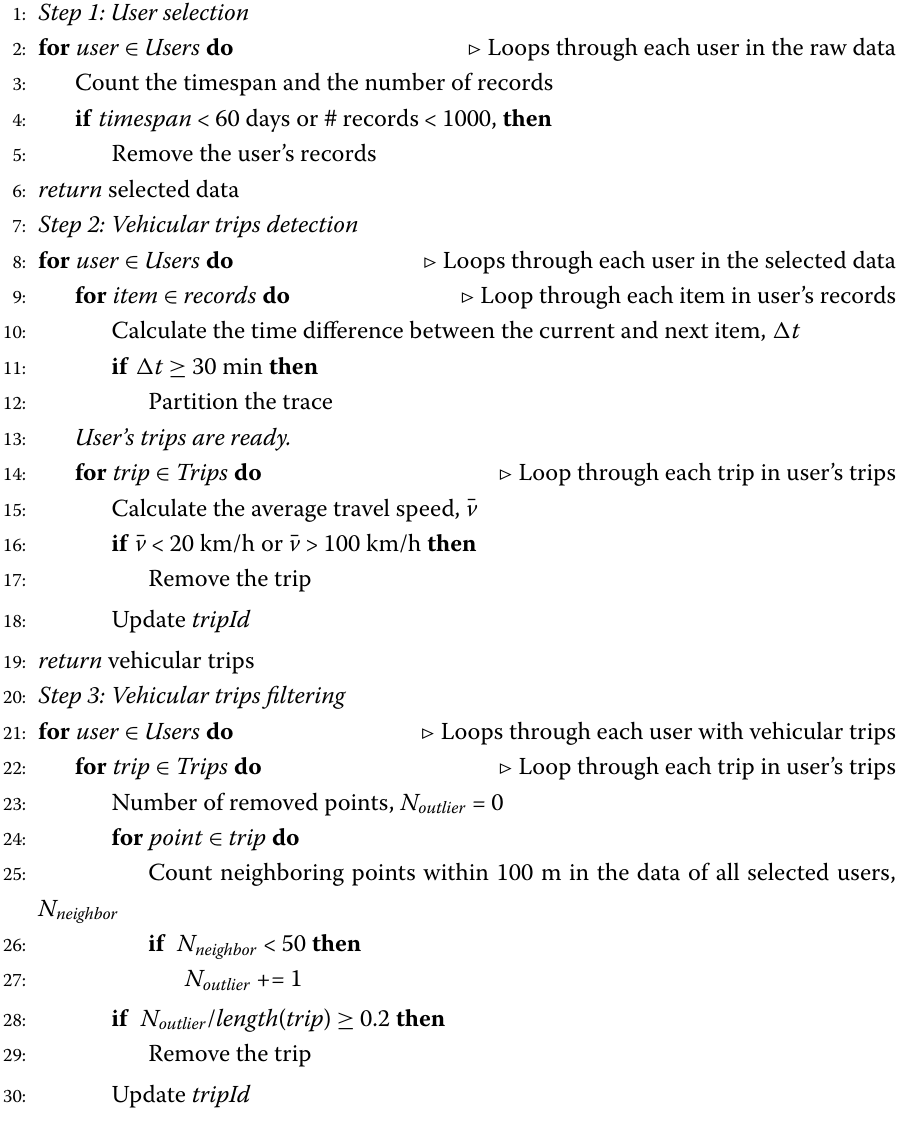
Algorithm 1 Vehicular Trips